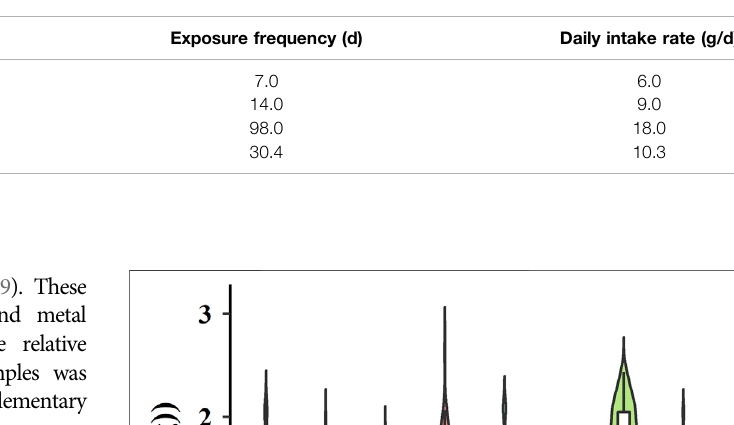
TABLE 1 | Consumption characteristics of Pheretima .